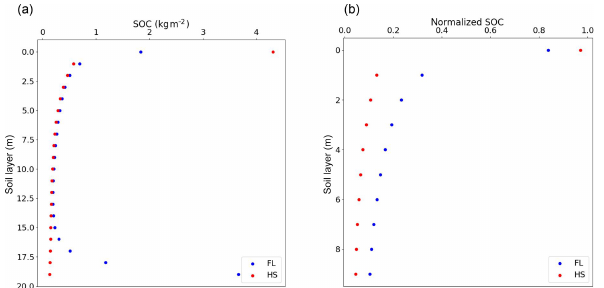
Figure 9. (a) Vertical distribution of hillslope (red) and floodplain (blue) SOC stocks (kg m − 2 ) with depth averaged over the non- Alpine region of the Rhine catchment and (b) the vertical distribu- tion of normalized hillslope (red) and floodplain (blue) SOC stocks (dimensionless) with